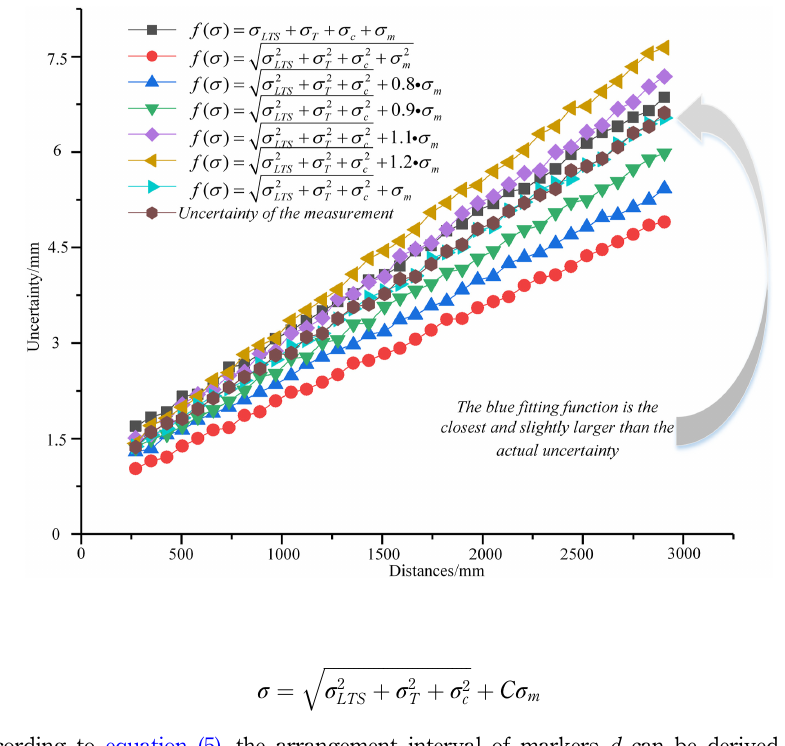
Figure 3. Functional relationships between uncertainties and movement distances are simulated and the results of simulation are distinguished by different